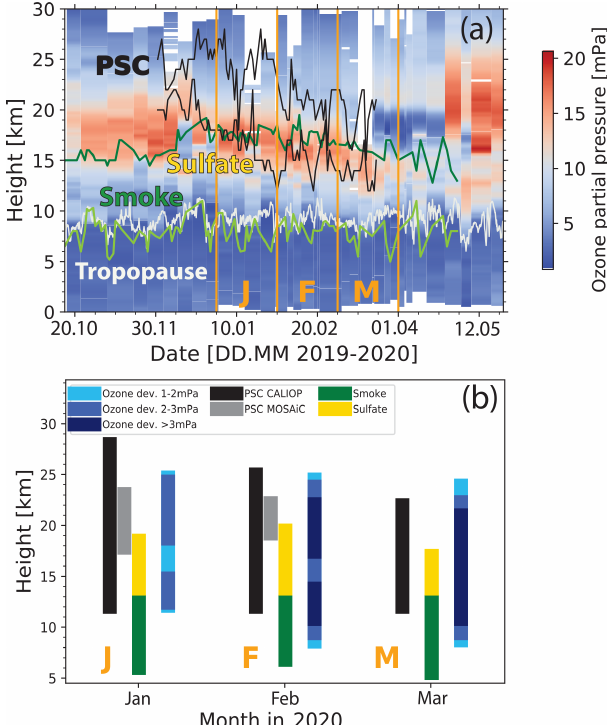
Figure 18. (a) Height–time display of the ozone partial pressure observed with ozonesondes launched at Polarstern . The PSC height range (according to daily CALIPSO lidar observations between 60 and 80 ◦ N) is indicated by black lines. The UTLS smoke and sul- fate aerosol layer from base (green) to top (dark green) as observed with the MOSAiC lidar over Polarstern (at > 85 ◦ N) is indicated as well. The white line shows the tropopause. (b) Height range with negative ozone deviation of 1–2mPa (light blue), 2–3mPa (blue), and > 3mPa (dark blue) from the long-term climatological monthly mean (2003–2019) at 90 ◦ N (as given in Fig. 6c1–c4 in Inness et al., 2020). The ozone deviations are shown as mean values for January (J), February (F), and March (M), as indicated in (a) . The black and grey vertical bars indicate the height ranges in which PSCs were detected with the CALIPSO lidar (as in a ) and with the Polarstern lidar (at > 85 ◦ N), respectively. The combined yellow–green bars indicate the UTLS aerosol layer, with the main layer containing wildfire smoke and a volcanic sulfate layer on